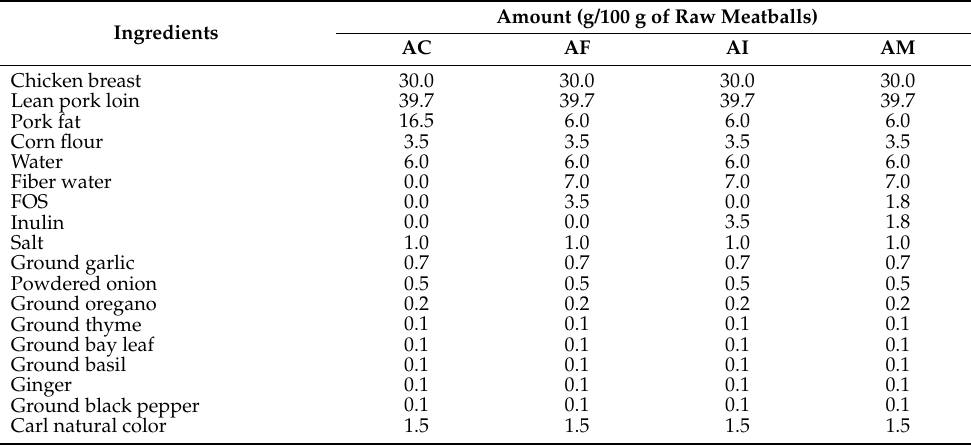
Table 2. Formulation of pork and chicken meatballs with added inulin and/or